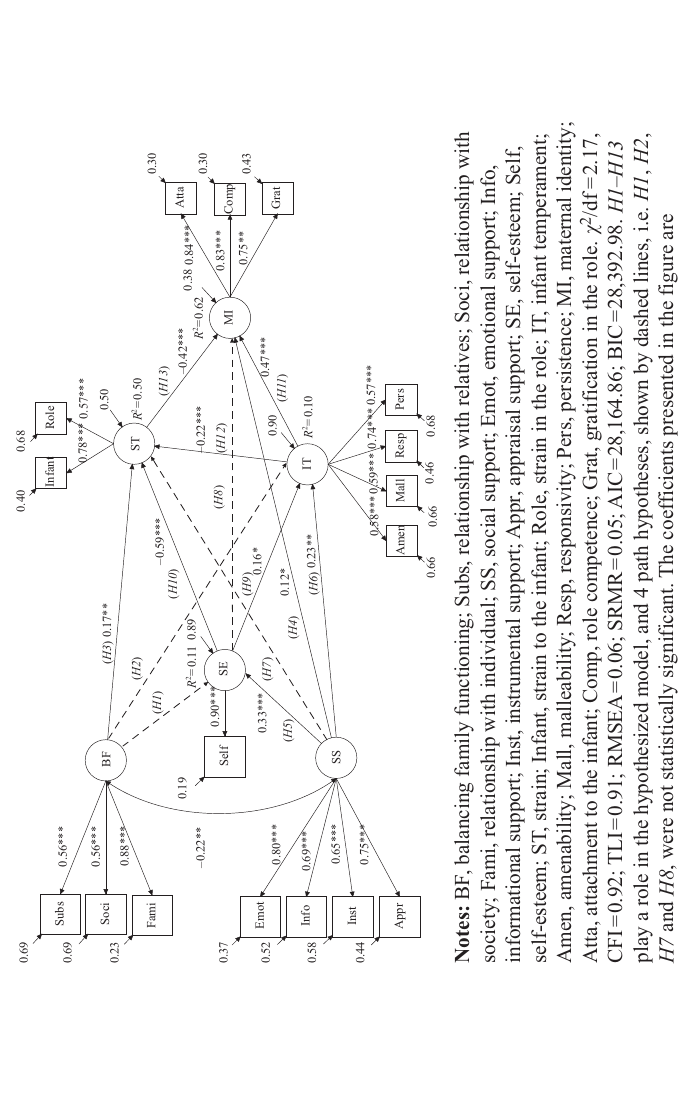
Figure 1. The causal model of the maternal identity among primiparous Thai teenage